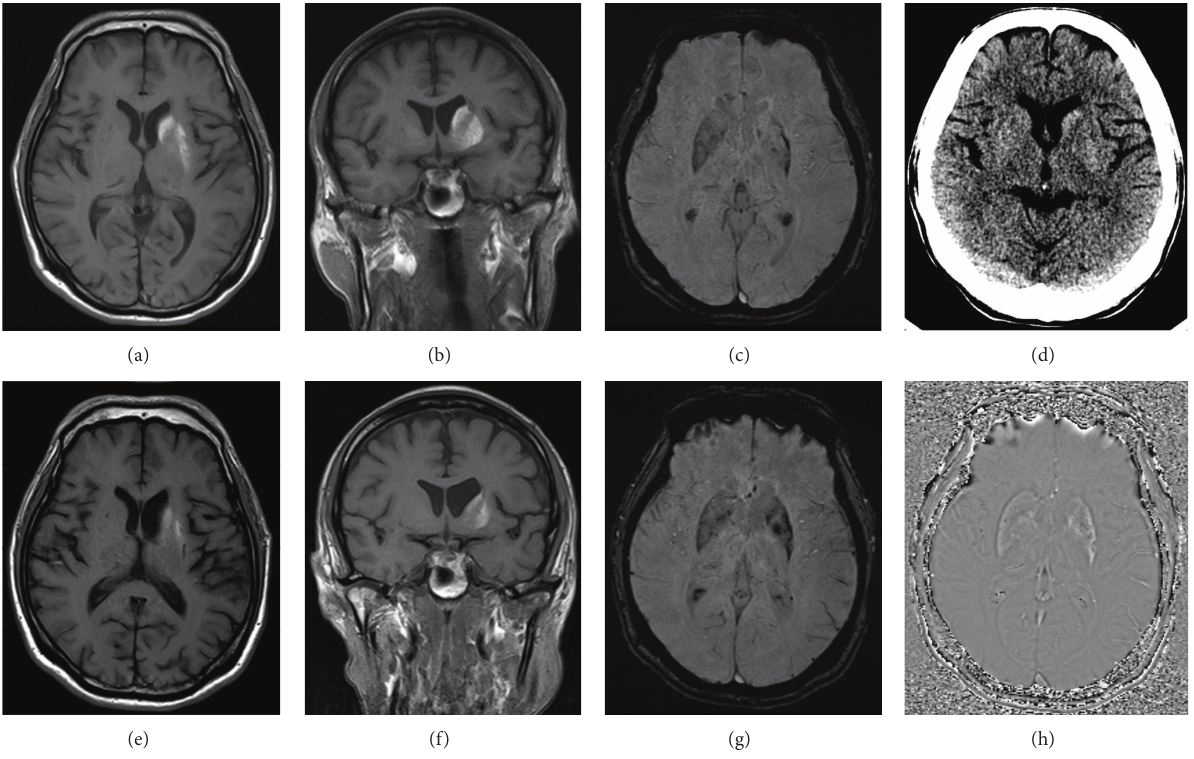
Figure 1: MRI changes in the left corpus striatum related to hemichorea hyperglycaemia. Top row: initial MRI head shows abnormal hyper- intensity in the left caudate head and left putamen on axial and coronal T1W MRI (a) and (b). Asymmetric low signal was noted along the lateral margin of the left putamen on SWI (c). On NECT head (d) there is corresponding increased attenuation in the left corpus striatum. Bottom row: MRI head performed five months later shows volume loss of the entire left corpus striatum, cystic foci of malacic change in the posterolateral putamen along with partial resolution of the hyperintensity on axial and coronal T1W MRI (e) and (f). There was progression in extent and degree of hypointensity within the left corpus striatum on SWI (g) with corresponding hyperintensity on filtered phase SWI